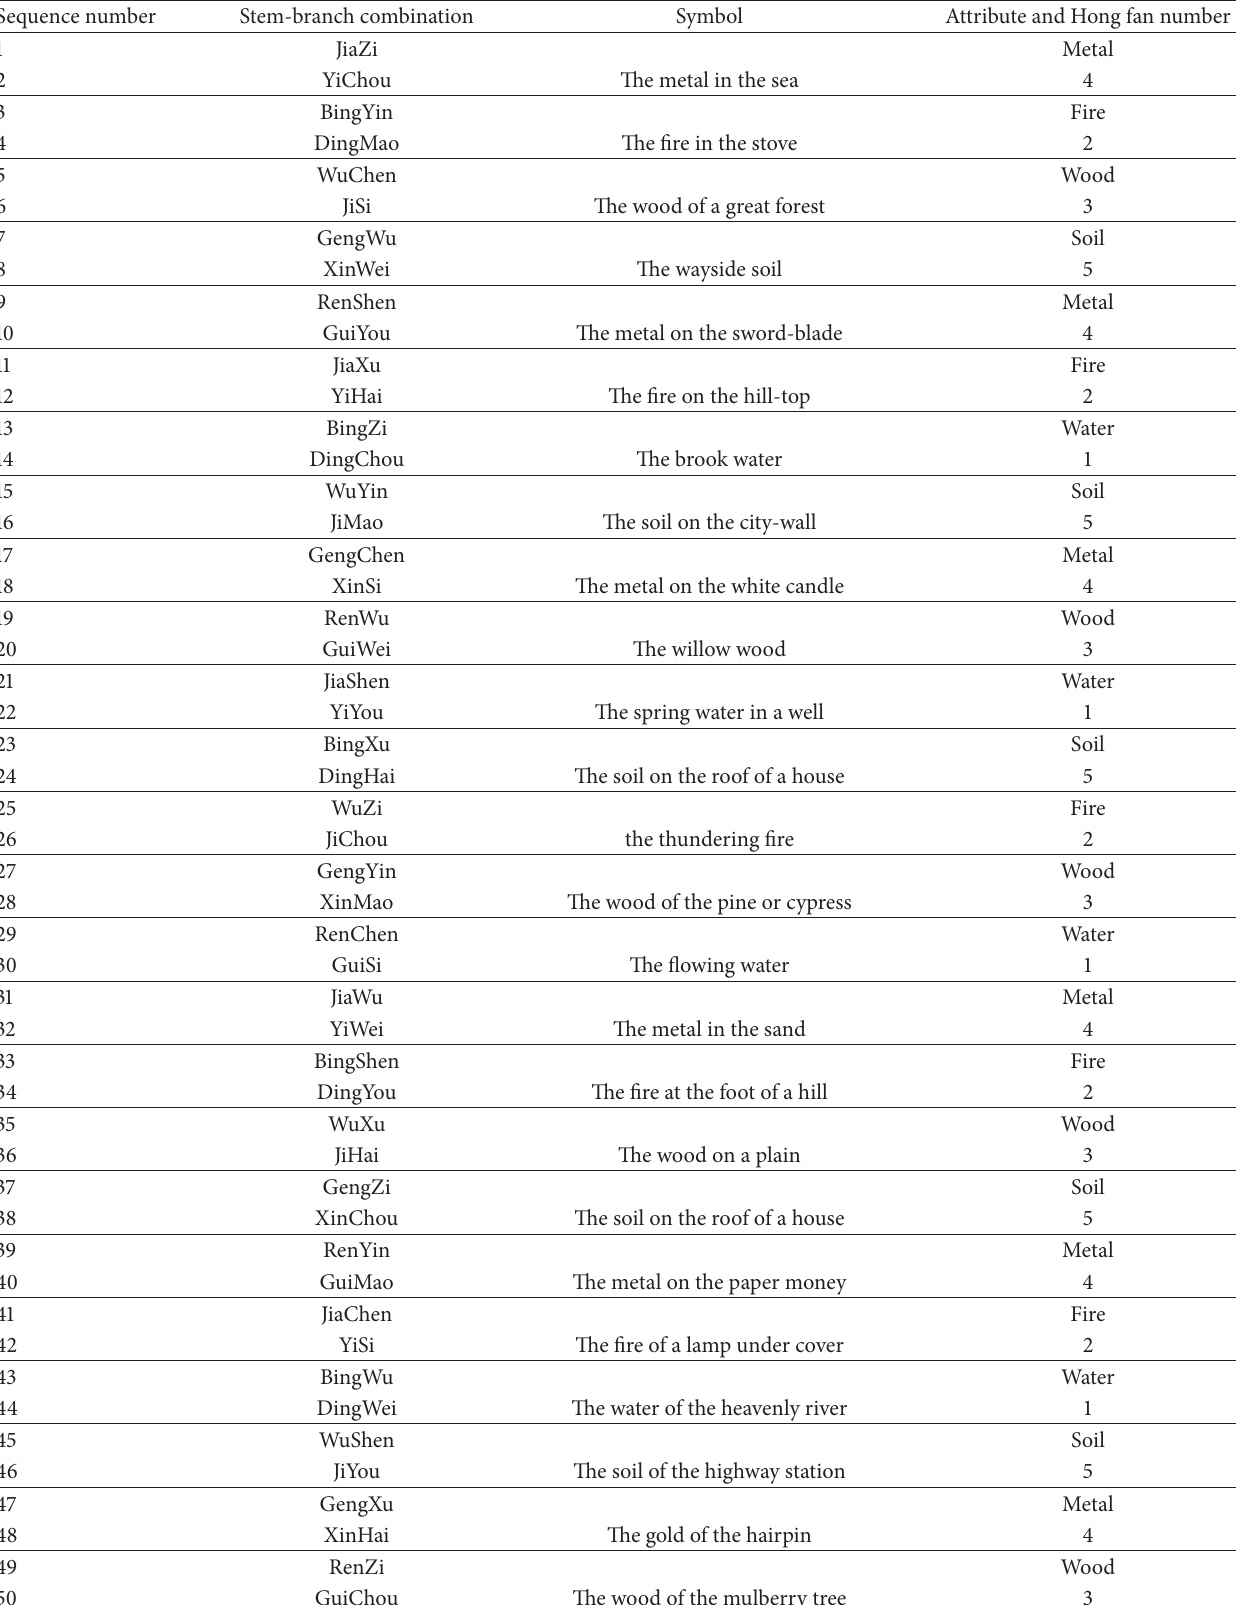
Table 1: Associated stem-branch combinations, symbols, and the attributes and Hong fan numbers of five elements. Sequence